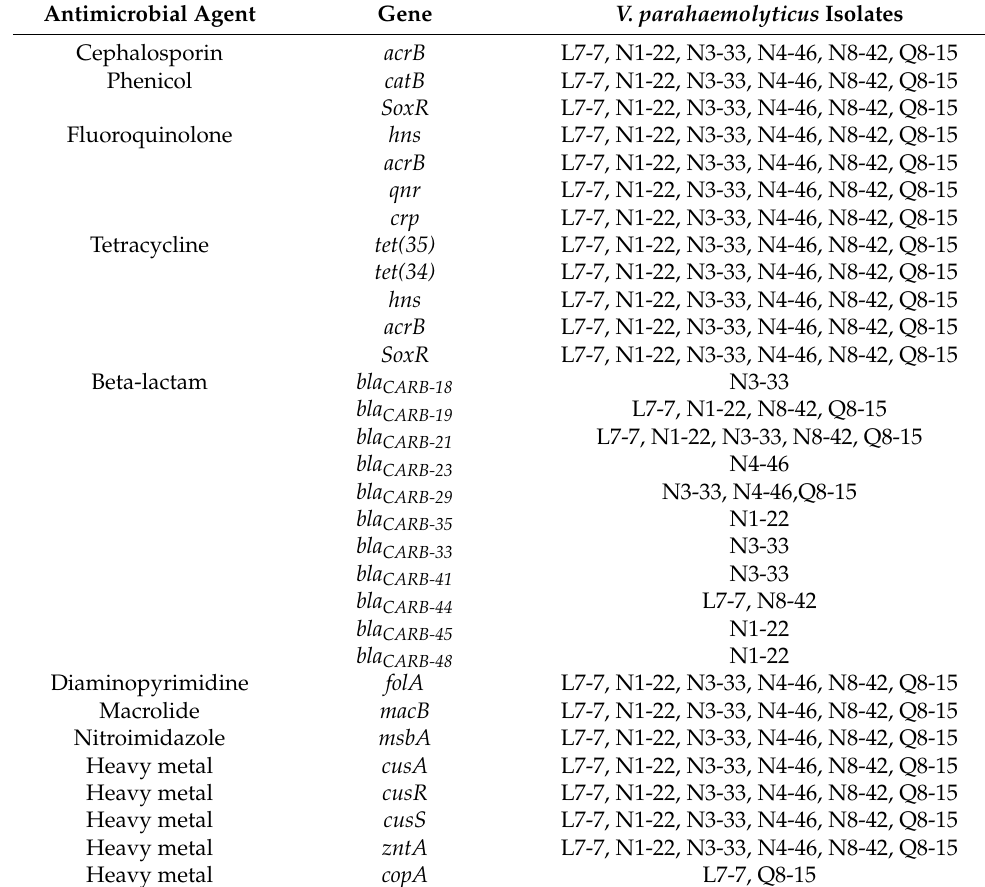
Table 2. The antimicrobial and heavy metal resistance-associated genes identified in the six V. parahaemolyticus